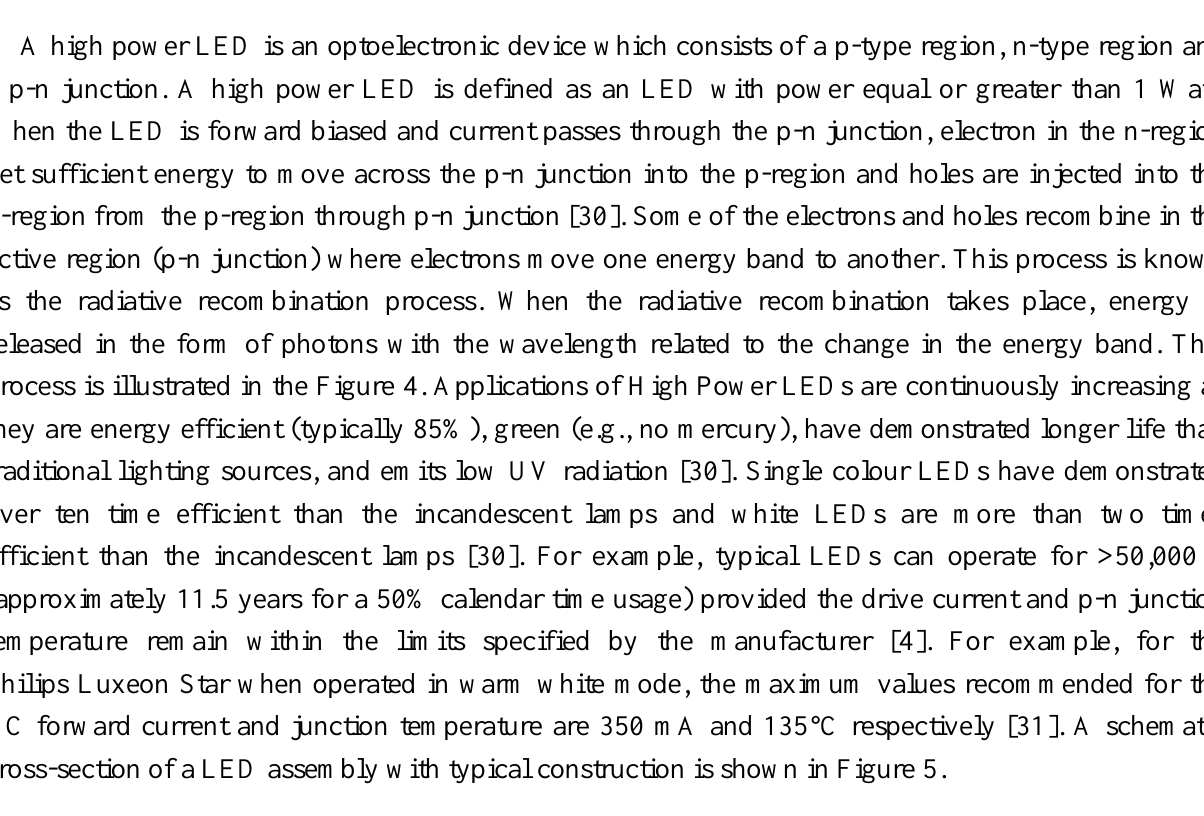
Figure 4. Radiative recombination process in the p-n junction (LED die) where the photon emitted in the form of